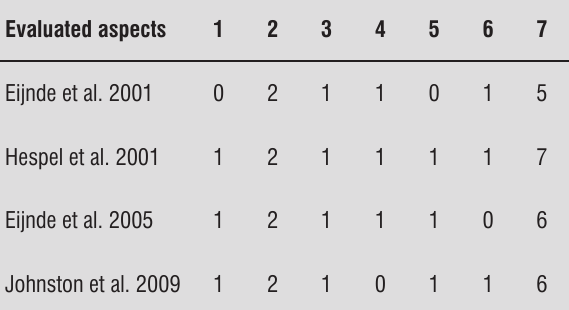
Table 1 - Scoring system used in the study and the score of four articles reviewed in